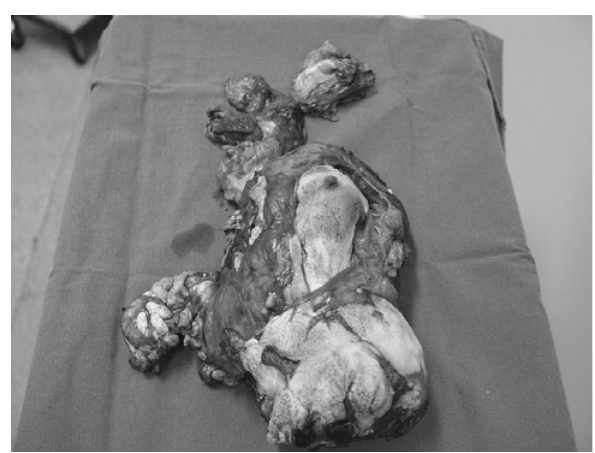
Fig. 3 - Aspecto final da massa após retirada